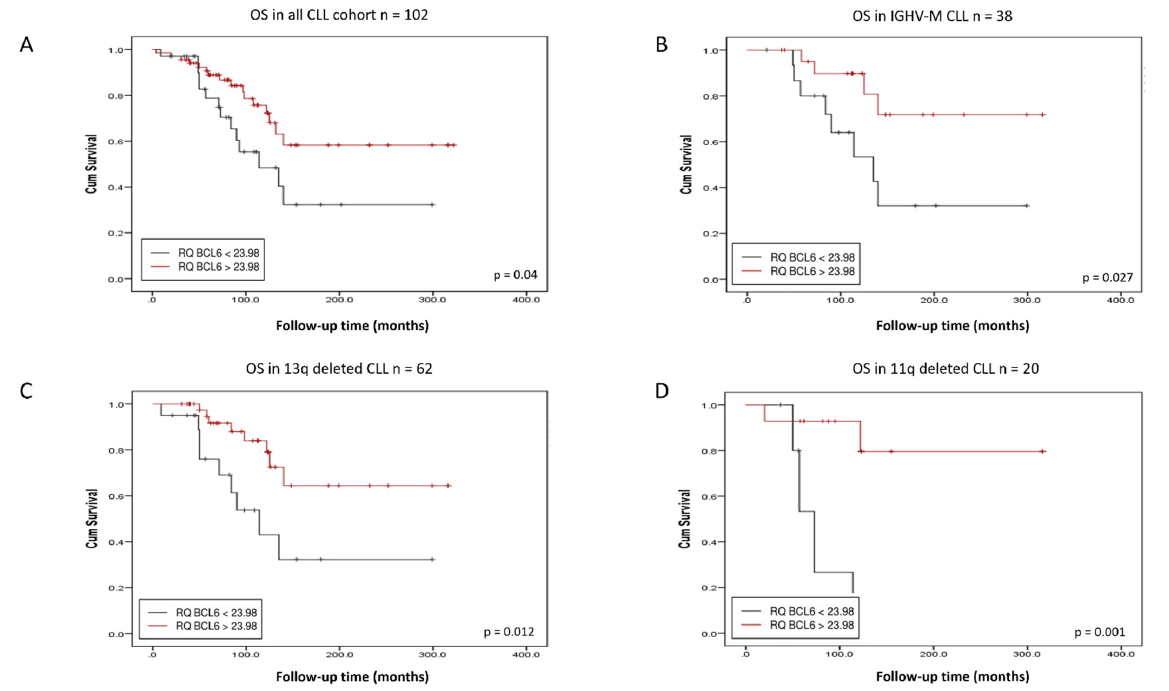
Figure 3. Kaplan–Meier analysis of CLL patients stratified by BCL6 RNA expression. BCL6 low expression predicts shorter overall survival in the whole cohort ( A ), in immunoglobulin heavy chain variable region-mutated (IGHV-M) patients ( B ), in 13q-deleted patients ( C ) and in 11q-deleted subgroups ( D ).